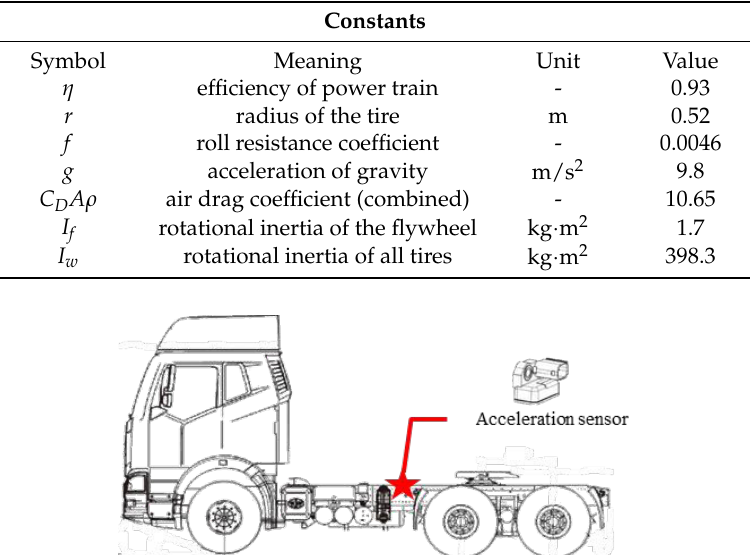
Table 2. Parameters in road test.